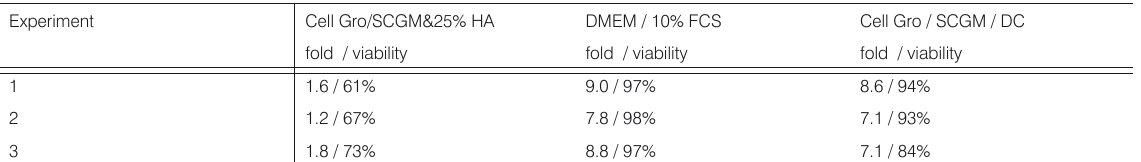
Figure 2. Expansion fold on Day 14. Different initial concentrations of CD34+ cells incubated in different culture medium. Cell concentration 10 5 /mL are expanded better than 10 4 / mL especially in serum free